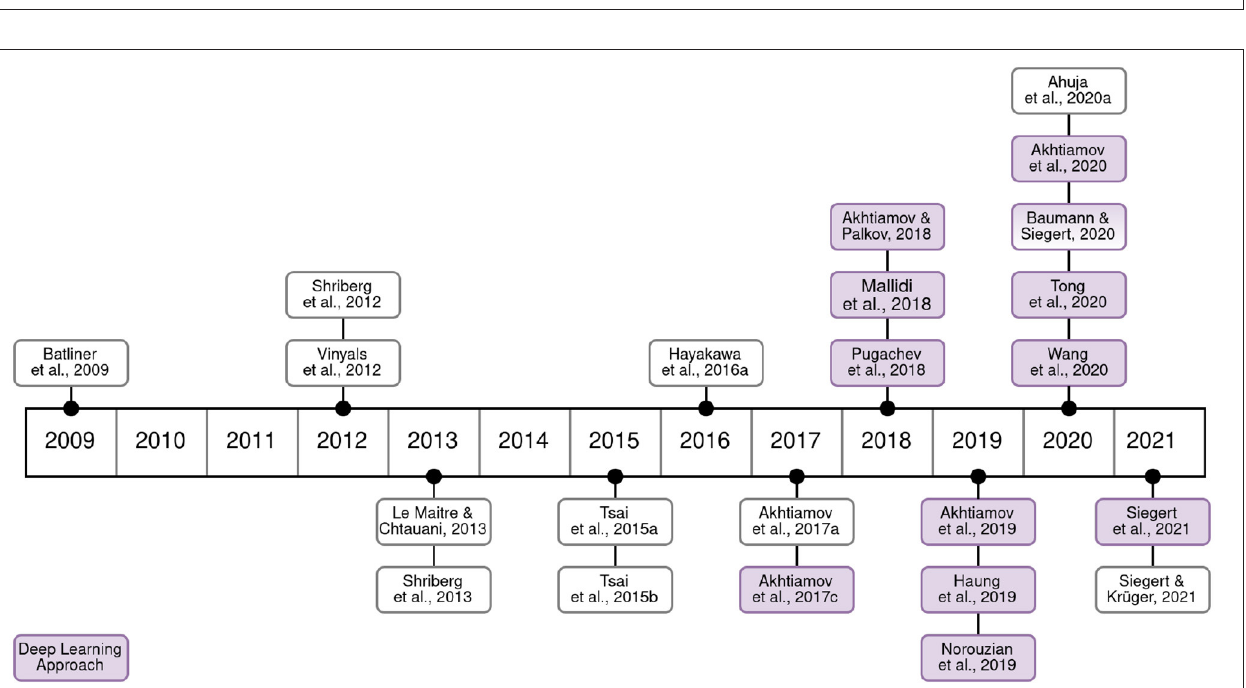
FIGURE 3 | Timeline of the 23 identified studies, studies using deep learning are highlighted.